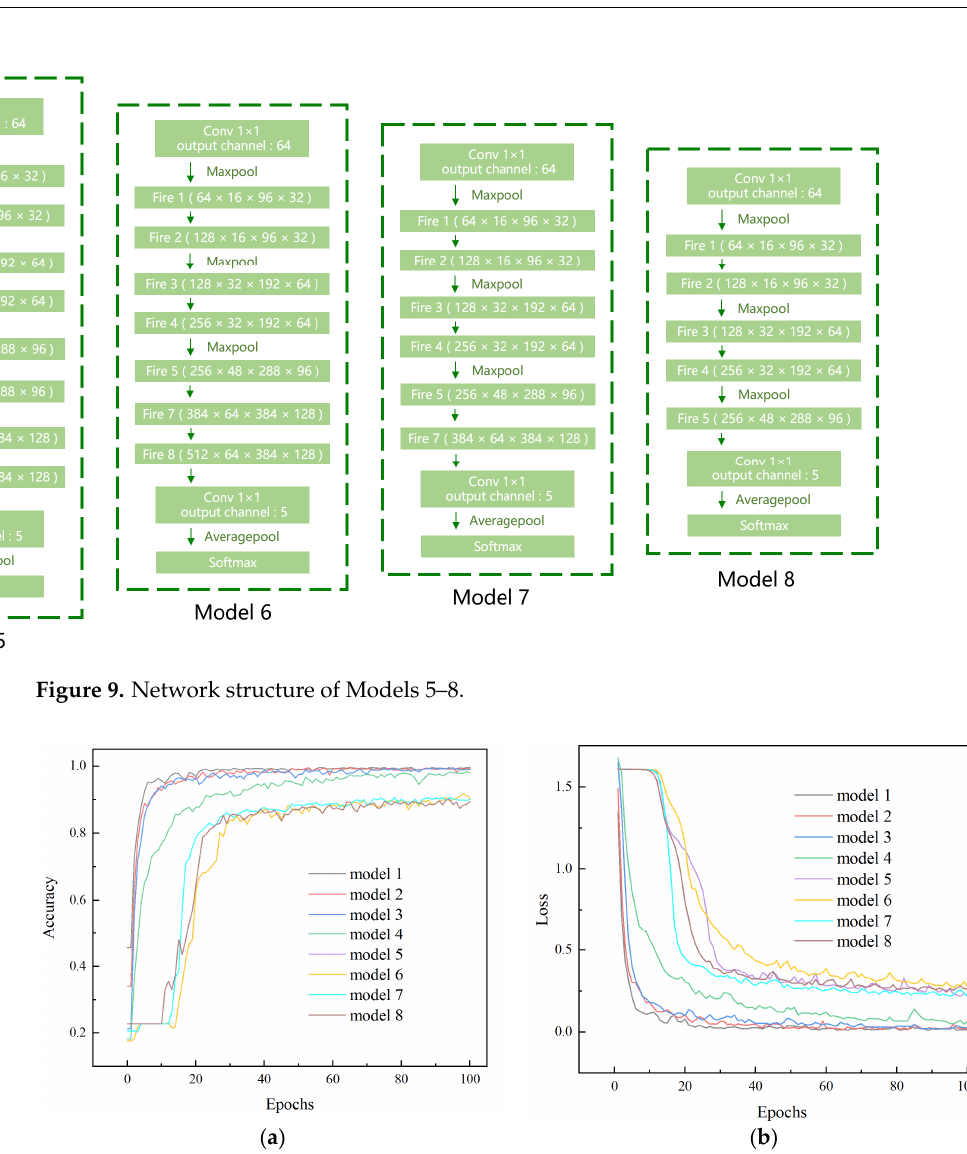
Figure 10. Results of Models 1–8 on the training set: ( a ) Comparison of accuracy; ( b ) Comparison of loss values.